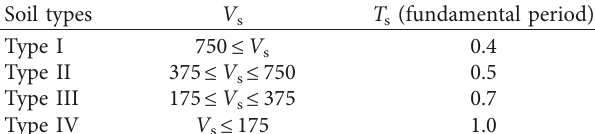
Table 1: Soil classification in Iranian national building codes [33].